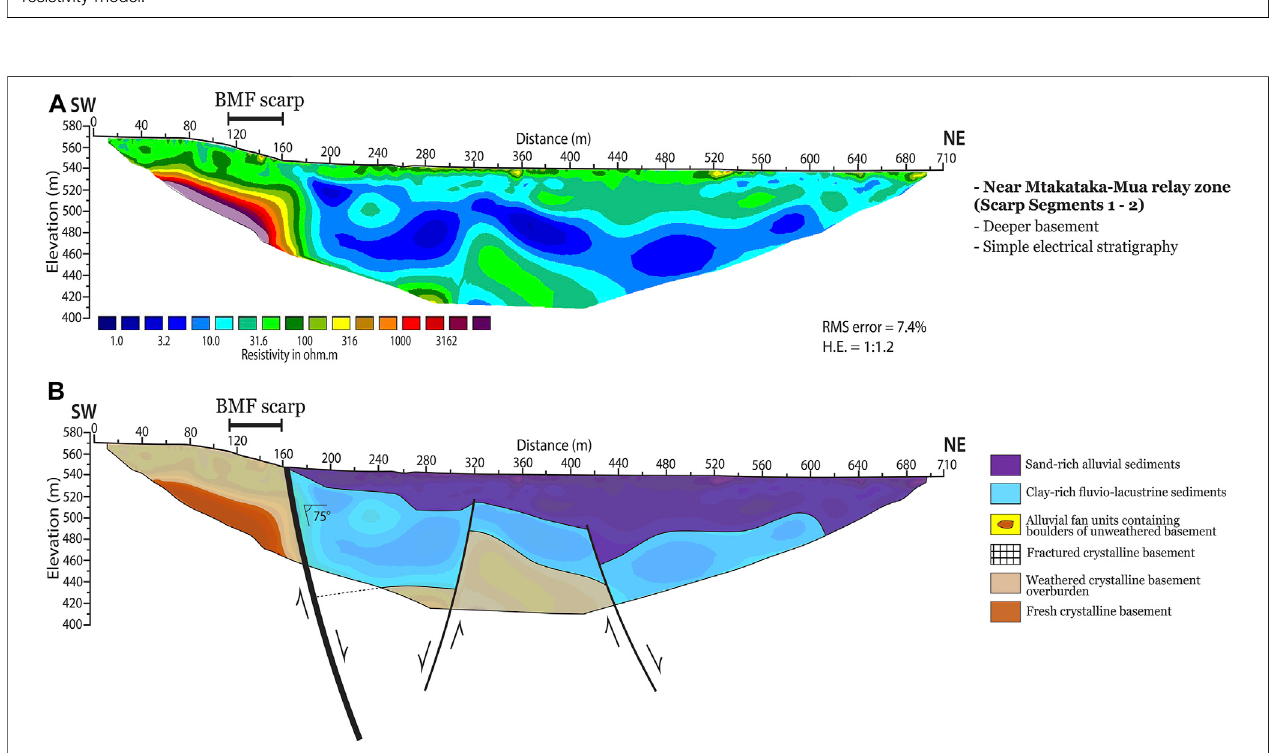
FIGURE8|(A) InversemodeloftheERTPro fi le2acquirednearthezoneofsegmentation(relayzone)betweenScarpSegments1and2(transitionfromMtakataka to Mua geometrical segments) in the northwestern section of the Bilila-Mtakataka Fault (BMF) ( Figure 2C ). The white transparent polygons are areas of low model sensitivity ( Supplementary Figure S1B ). (B) Geologic model and interpretation of the resistivity model.